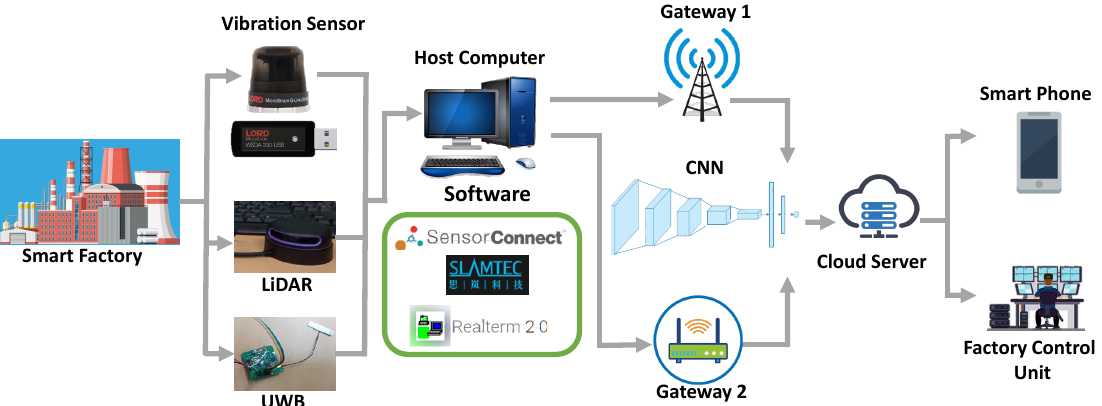
Figure 1. System model showing the vibration sensor, LIDAR, and ultra-wide band (UWB) sensor for the data collection. We have also Implemented the AI algorithms on the host